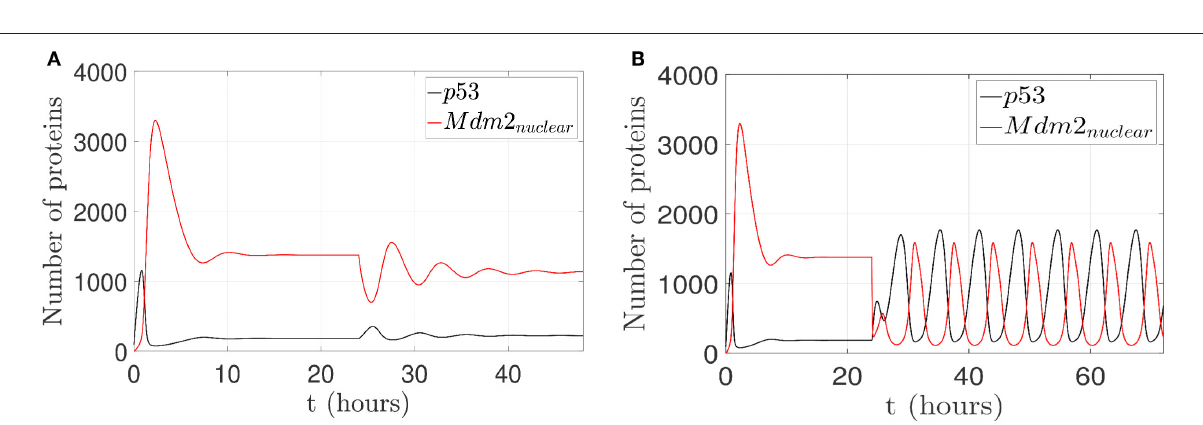
Frontiers in Physiology |